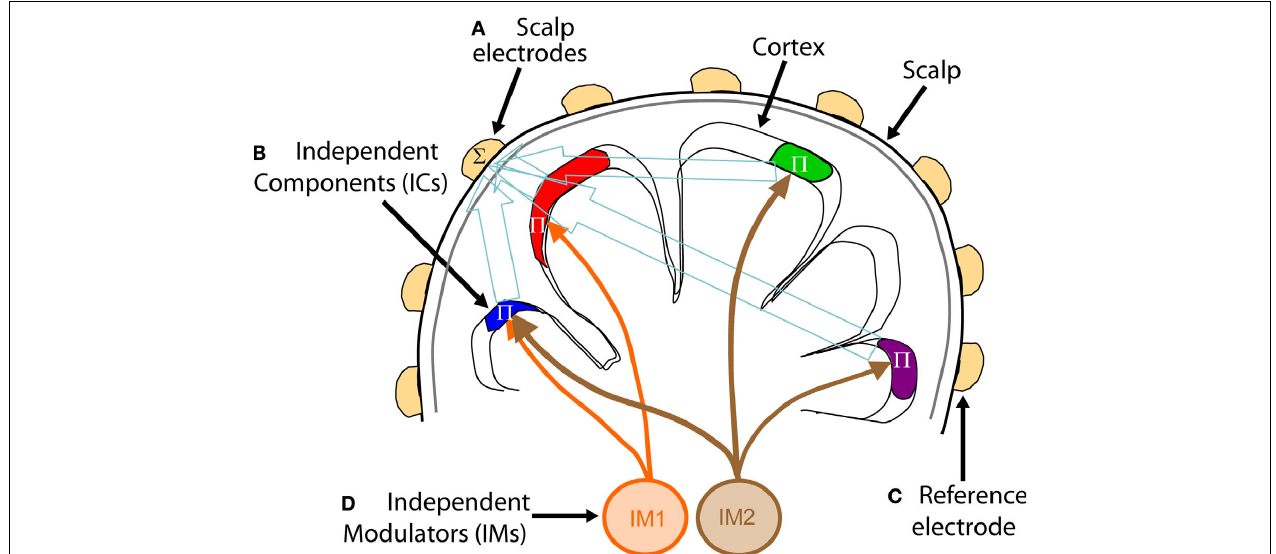
time. Rather than viewing these variations as occurring independently at each frequency, spectral modulations may be modeled as exponentially weighted infl uences of several distinct but possibly overlapping modulator (IM) processes (D) that independently modulate via multiplicatively scaling ( Π ) the activity spectra of one or more independent component (IC) signals. On converting the IC spectra to log power, combined IM infl uences on IC spectra are converted to log-linear weighted sums of IM infl uences, allowing a linear ICA decomposition of the IC log-power spectra to separate the effects of the individual